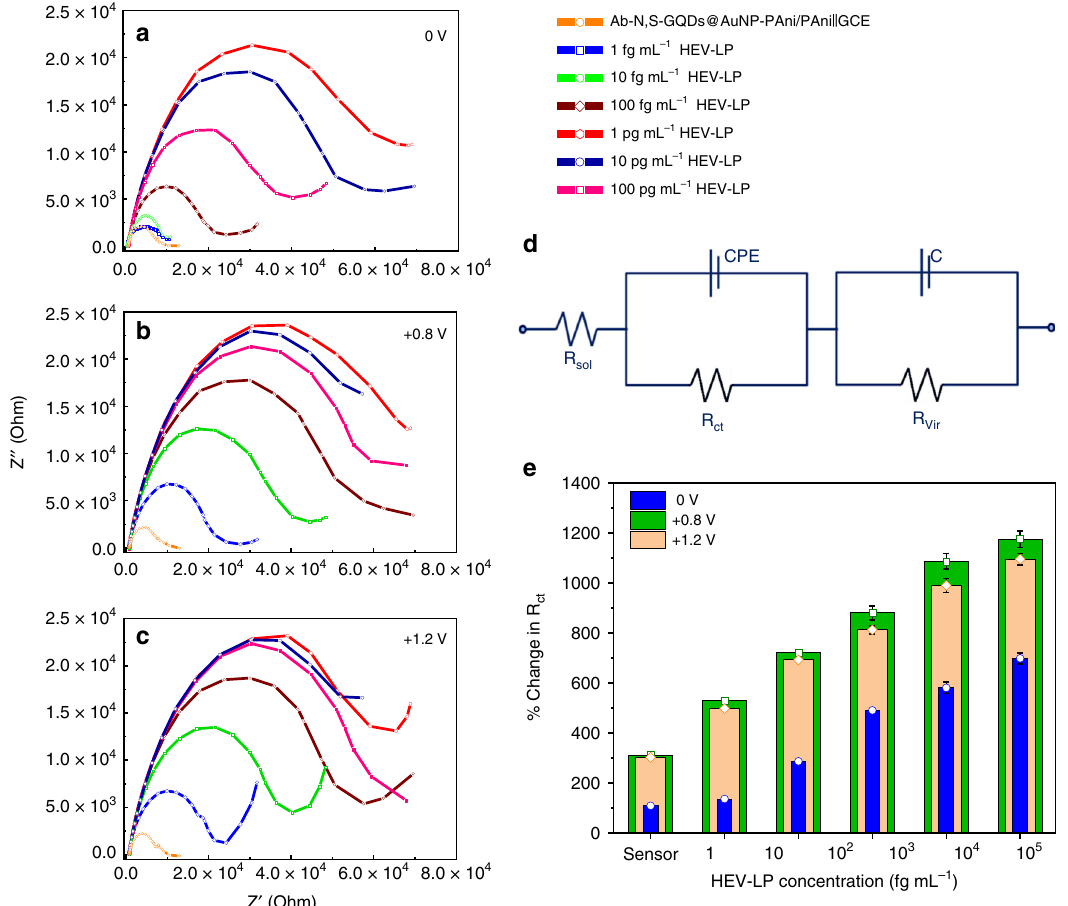
Fig. 4 Electrochemical impedimetric performances over electric pulse on the sensor electrode with different virus concentration: EIS of Ab-N,S- GQDs@AuNP-PAni/PAni||GCE sensor electrode before and after incubation with 1 fg mL − 1 to 100 pg mL − 1 of HEV-LP with external pulses of a 0 V, b + 0.8 V, and c + 1.2 V. Circuit diagram of the proposed sensor ( d ) and comparative diagram of percentage change in R ct values in three pulse conditions ( e ). Error bars represent the standard deviation of triple